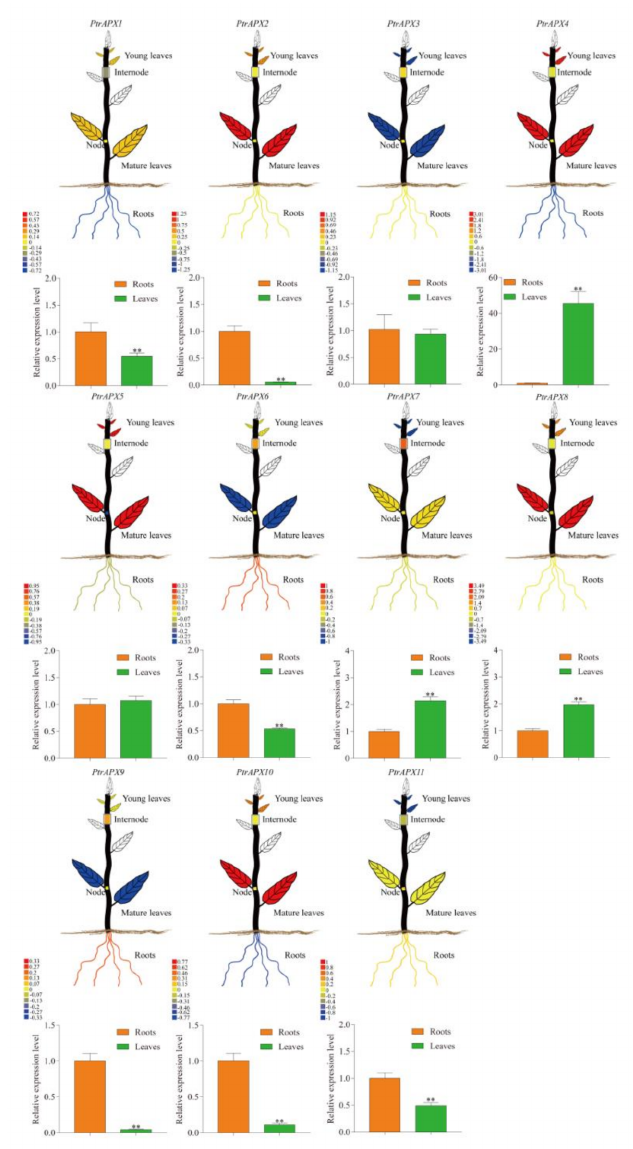
Figure 7. Tissue-specific expression profiles of PtrAPX genes. The visual image for each PtrAPX gene in P. trichocarpa was obtained from PopGenIE [43]. Error bars represent the standard deviations from three biological replicates. Asterisks indicate stress treatment groups that showed a significant difference in transcript abundance compared with the control group (** p <